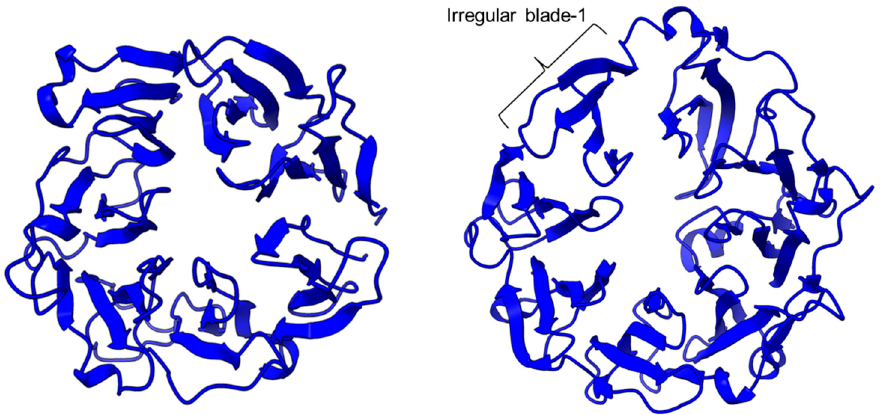
Figure 2. The β -propeller structure of a porcine prolyl oligopeptidase POP (PDB id: 1QFM, left) and a human dipeptidyl peptidase DPP-IV (PDB ID: 1J2E, right). The labeled irregular blade-1 of the eight-blade β -propeller structure could contribute to different substrate specificity between POP and DPP-IV.